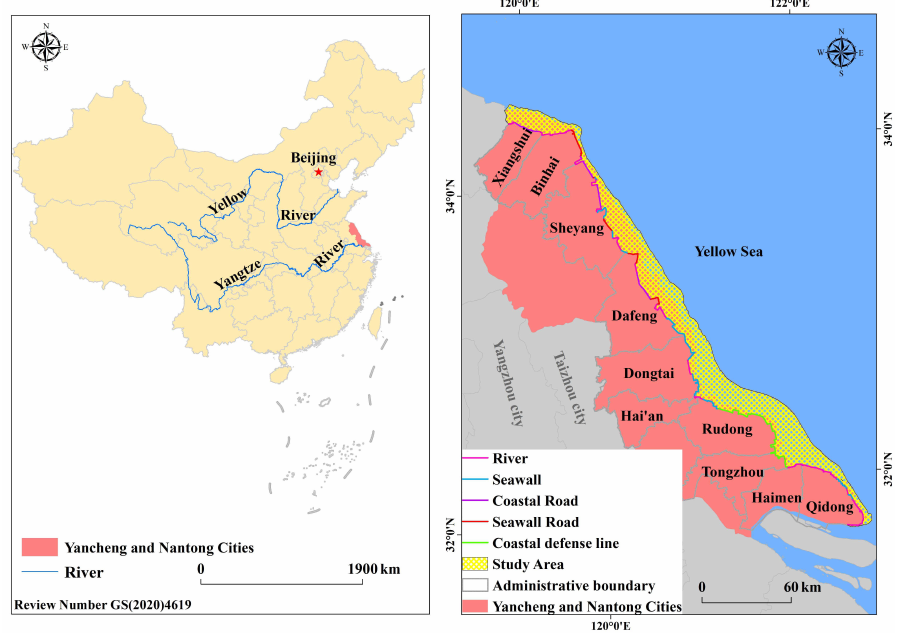
Figure 1. Location of the study